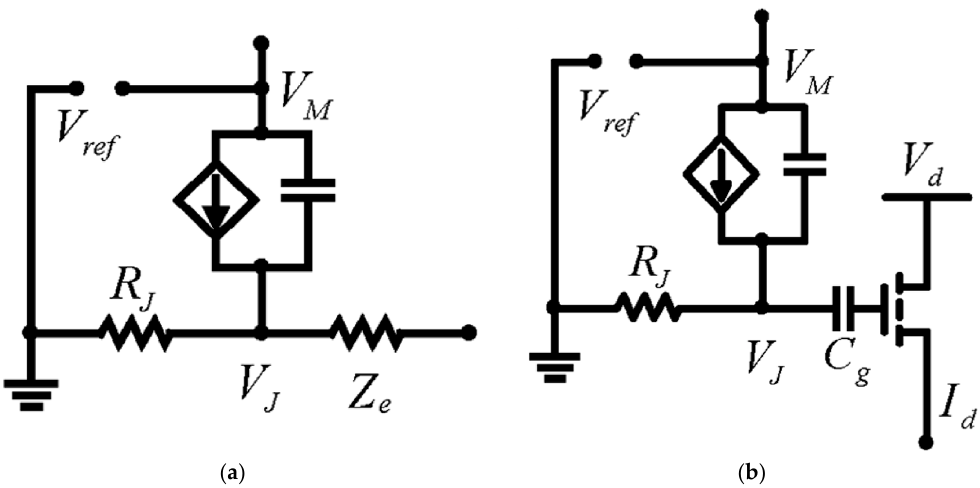
Figure 15. ( a ) Simple equivalent circuit model for extracellular recording with a micro-electrode; ( b ) Simple equivalent circuit model for extracellular recording with a micro-electrode. Reproduced from [40] with permission of The Royal Society of Chemistry. Copyright 2015. https://doi.org/10. 1039/C5TC00569H.